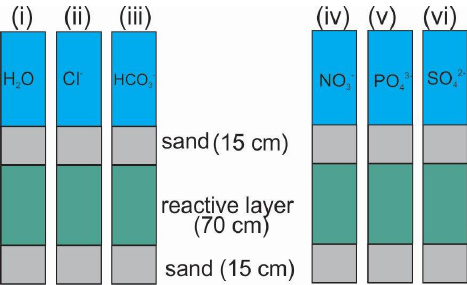
Figure 2. Filtration unit modules used to investigate of the impact of different anions on the